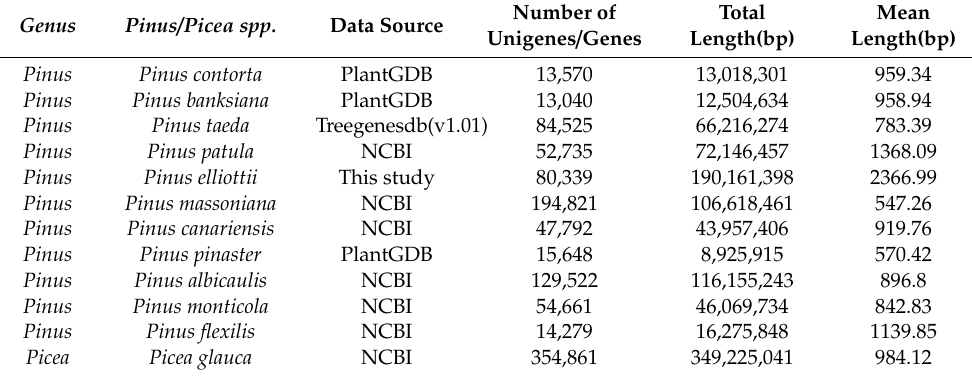
Table 2. The unigenes / genes of Picea glauca and 11 Pinus (including the P. elliottii data of this study). The PlantGDB represents that unigenes were obtained from PlantGDB—Resources for Plant Comparative Genomics (http: // www.plantgdb.org). The NCBI represents that unigenes / genes were obtained from National Center for Biotechnology Information (NCBI, https: // www.ncbi.nlm.nih.gov / ). Treegenesdb (v1.01) stands for that the genes of Pinus taeda were obtained according to genome assembly and general feature format of P. taeda (version v1.01).